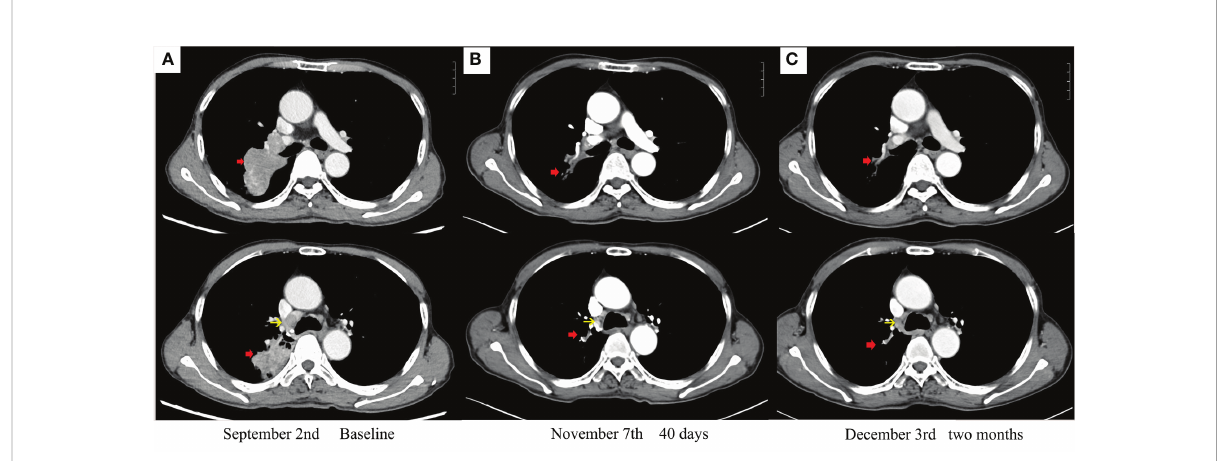
FIGURE 2 Enhanced chest CT scans during therapy: (A) baseline imaging. (B) After 40 days with savolitinib. (C) After 2 months with savolitinib. The red arrow indicates a primary tumor. The yellow arrow indicates metastatic lymph nodes.